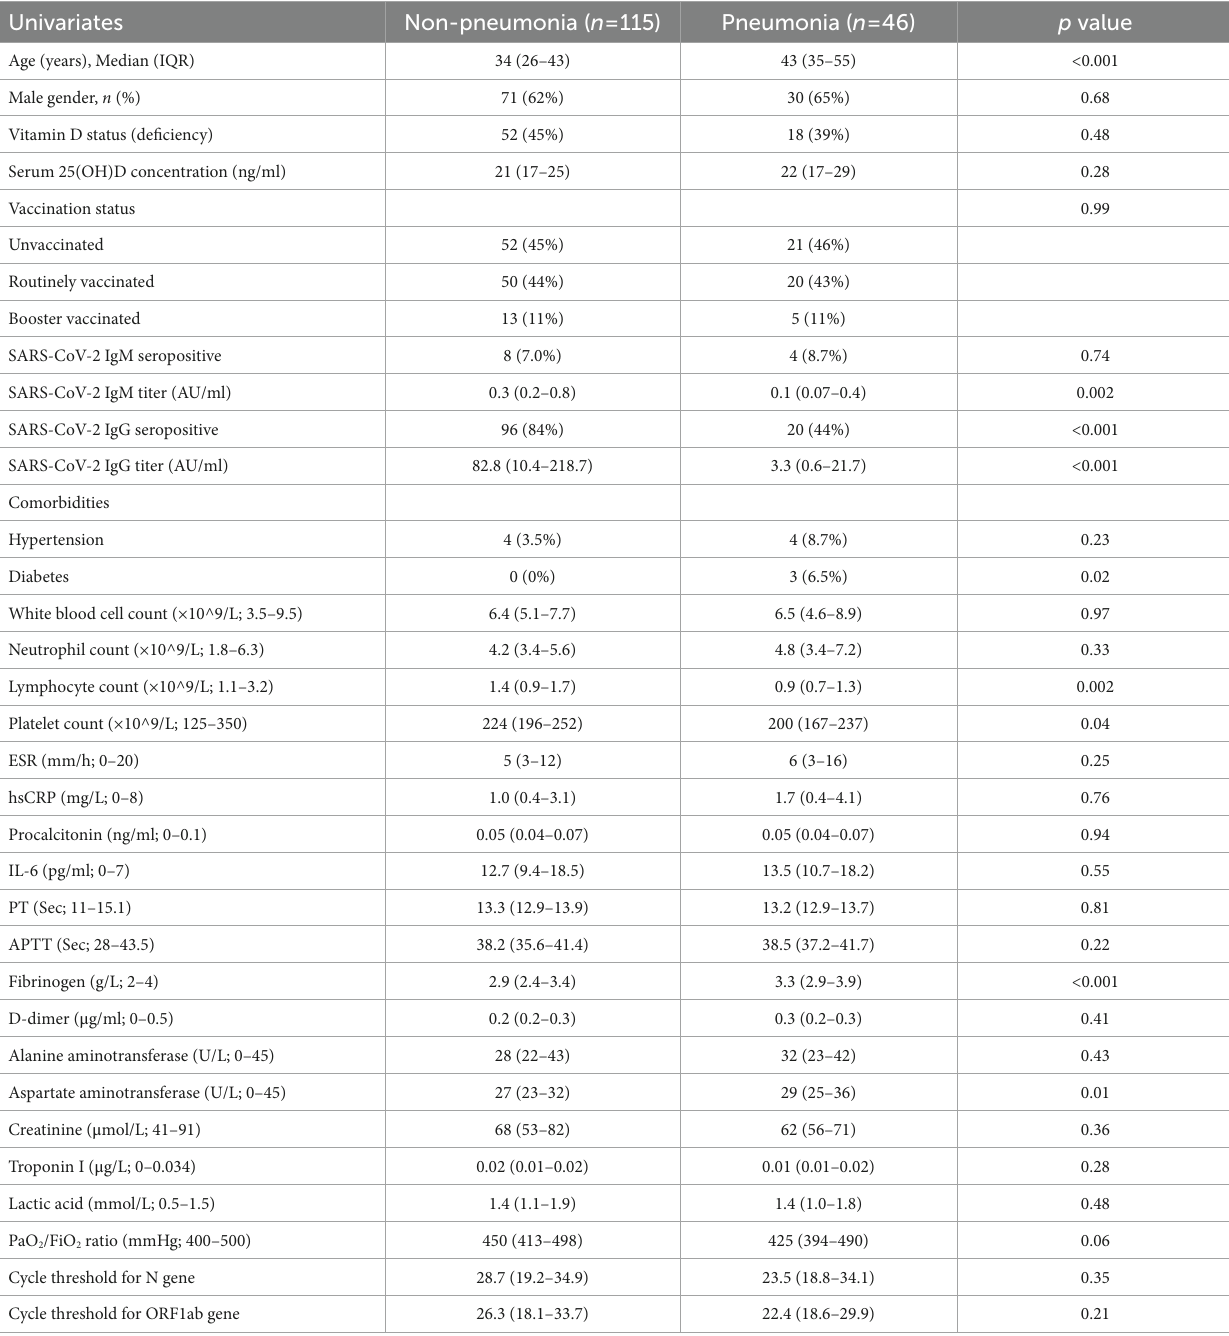
TABLE 1 Univariate comparison between the non-pneumonia and pneumonia groups on admission. Univariates Non-pneumonia ( n = 115) Pneumonia ( n = 46)